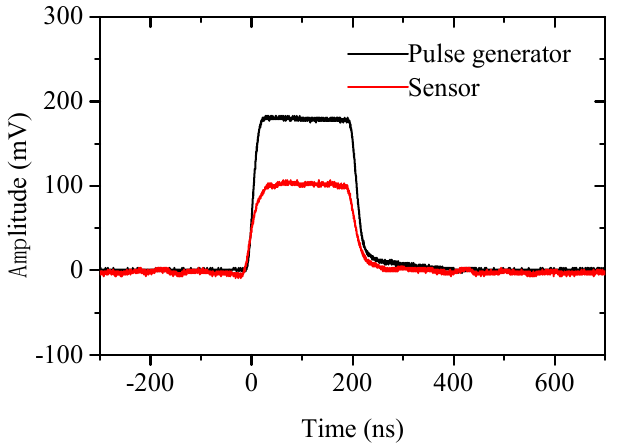
Figure 9. Typical calibration waveform.